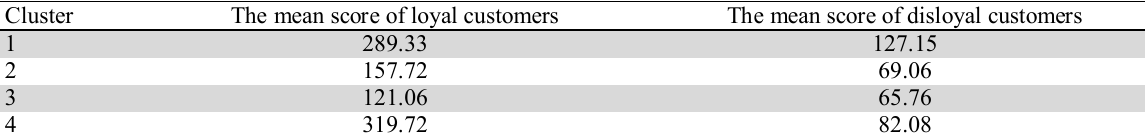
The mean score of customers in each cluster Cluster The mean score of loyal